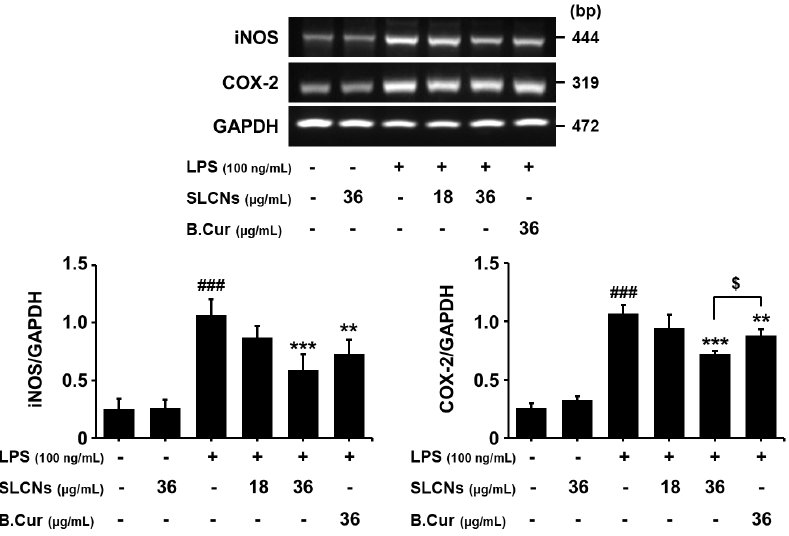
Figure 4. SLCN attenuates iNOS and COX-2 mRNA levels in LPS-stimulated BV2 cells. BV2 cells were pretreated with the indicated concentrations of SLCN and base curcumin for 1 h before being incubated with LPS (100 ng/mL) for 6 h (RT-PCR). Total RNA was prepared and analysed for iNOS and COX-2 gene expression by RT-PCR. Quantification data are shown in the lower panel. ### p < 0.001 vs. untreated group; ** p < 0.01 and ***i < 0.001 vs. LPS-treated group; $ p < 0.05 vs. SLCN-treated group (one-way ANOVA; n = 3). Molecules 2019 , 24 FOR PEER REVIEW